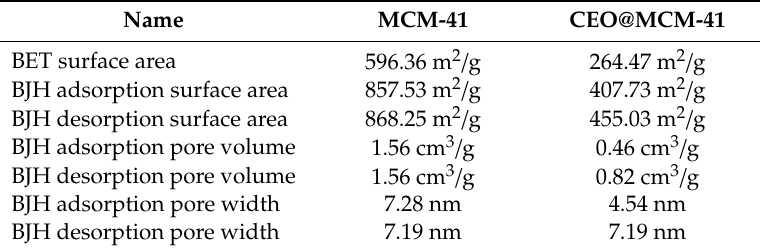
Table 1. Results of BET and BJH determination for MCM-41 and CEO@ MCM-41.